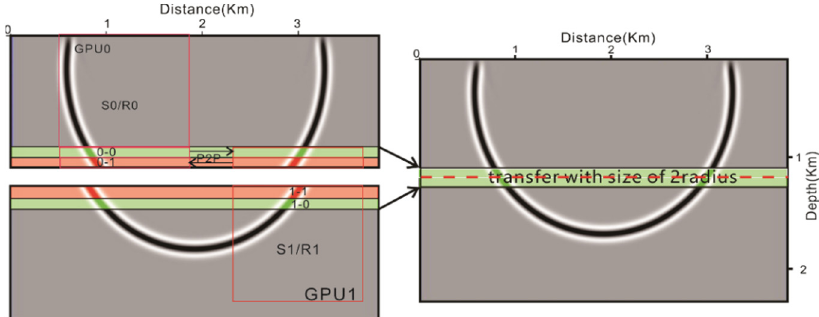
Figure 9. Calculation and data exchange of shot wavefields on 2 GPUs.